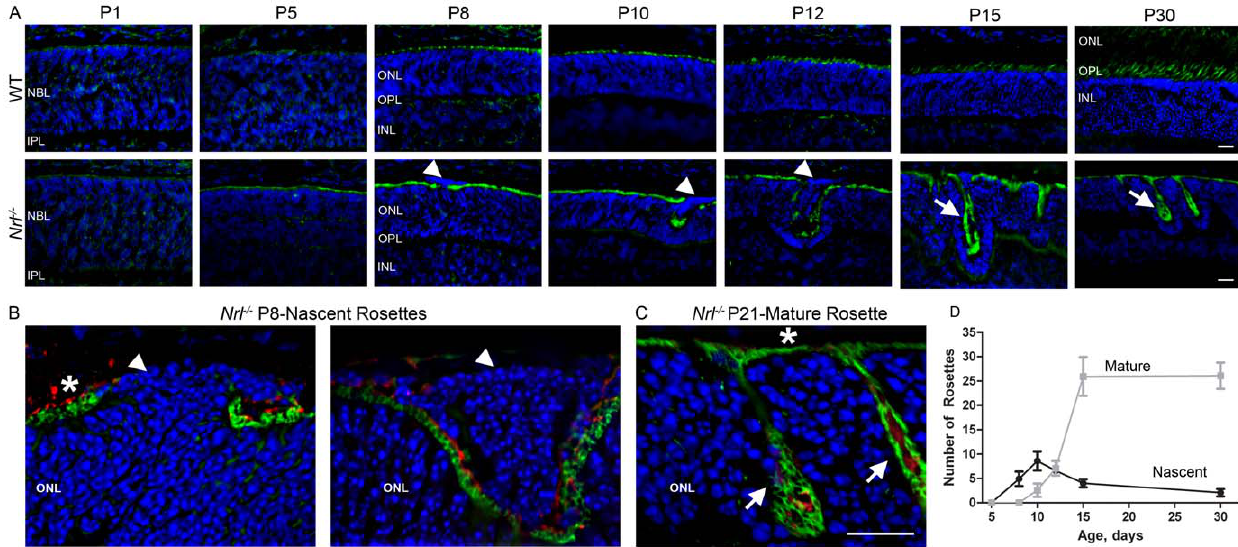
Figure 1. Development of rosettes. Retinal sections at the indicated ages were labeled with Alexa 488 conjugated peanut agglutin (PNA-green, A–C ) and S-opsin (red, B–C ). Small nascent rosettes (arrowheads) and mature rosettes (arrows) are observed. NBL: neuroblast layer, IPL: inner plexiform layer, ONL: outer nuclear layer, OPL; outer plexiform layer, INL: inner nuclear layer. Scale bar 20 m m D . Rosettes were counted in 3 sections/ eye, 4–5 eyes per age/genotype. Shown are means 6 SEM. Black line (squares)-nascent rosettes, Gray line (circles)-mature rosettes. marker S-opsin (red). Mature rosettes appear as undulations of the ONL filled with the OSs of the surrounding photoreceptors ( Figure 1C arrows). In contrast, the nascent rosettes in the developing retina contain not only early IS/OSs, but also a